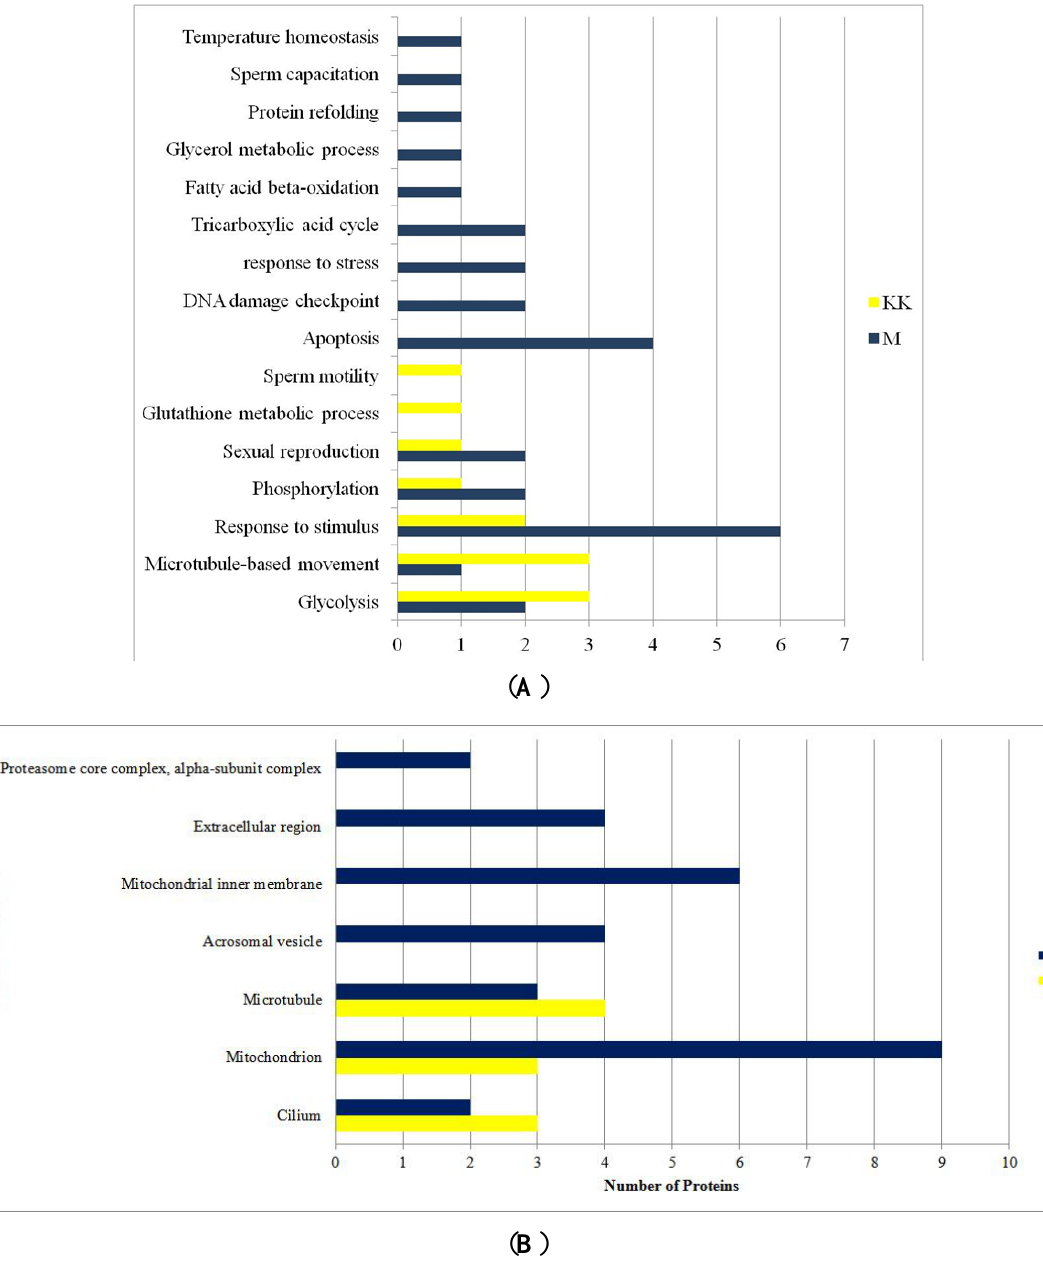
Figure 3. As a result of Gene Ontology (GO) analysis, regulated proteins from Kedah Kelantan (KK) and Mafriwal (M) sperm were classified based on their role in biological processes ( A ) and their location in the cell ( B